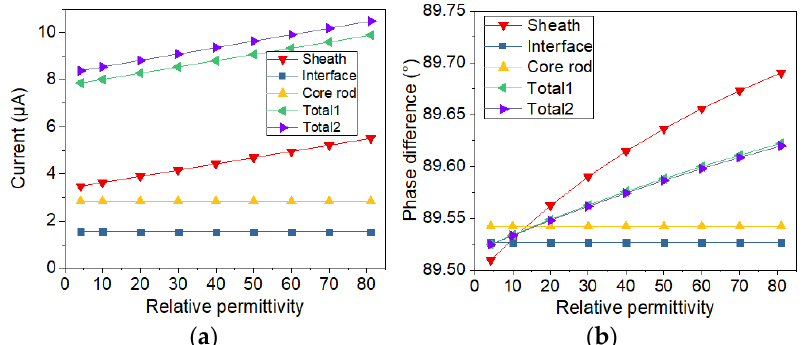
Figure 9. Current varying with relative permittivity of surface layer of sheath: ( a ) Change of current; ( b ) Change of phase difference.